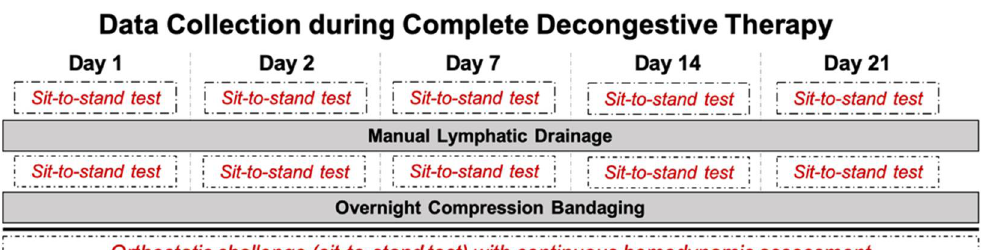
Figure 1. Detailed overview of data collection during complete decongestive therapy (CDT), as well as manual lymphatic drainage (MLD), over three weeks of lymphedema treatment. Sit-to-stand test was performed twice per day, before and after MLD, as indicated in the dashed boxes.